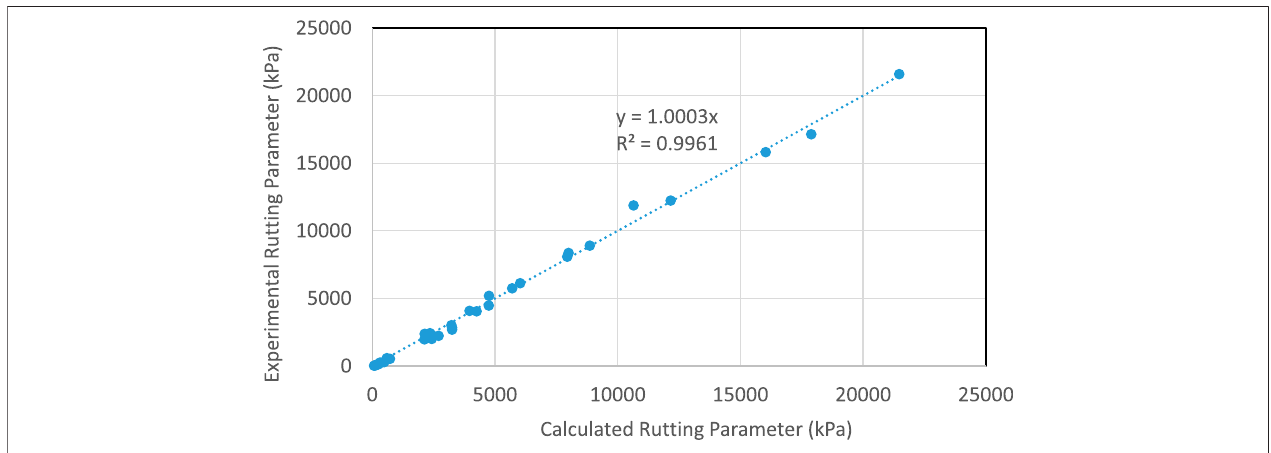
FIGURE 10 | Predicted vs. experimental rutting parameter for the aged unmodi fi ed CMAs: Modeling points.